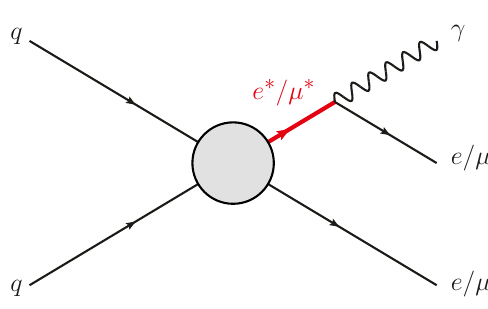
Figure 1 . The Feynman diagram of the production of excited leptons in ‘‘(cid:13) (cid:12)nal